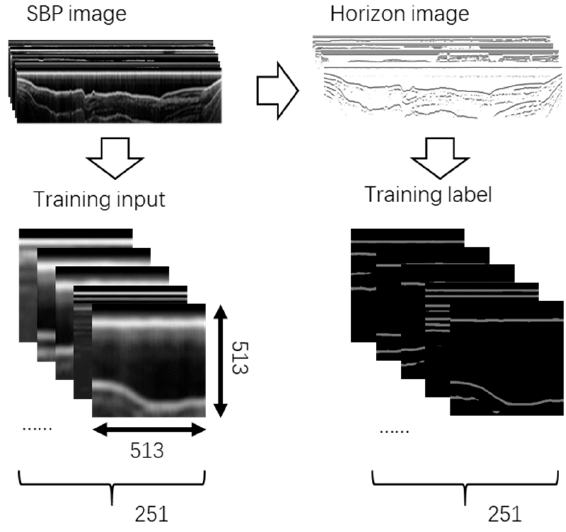
Figure 14. The generation process of the training dataset.